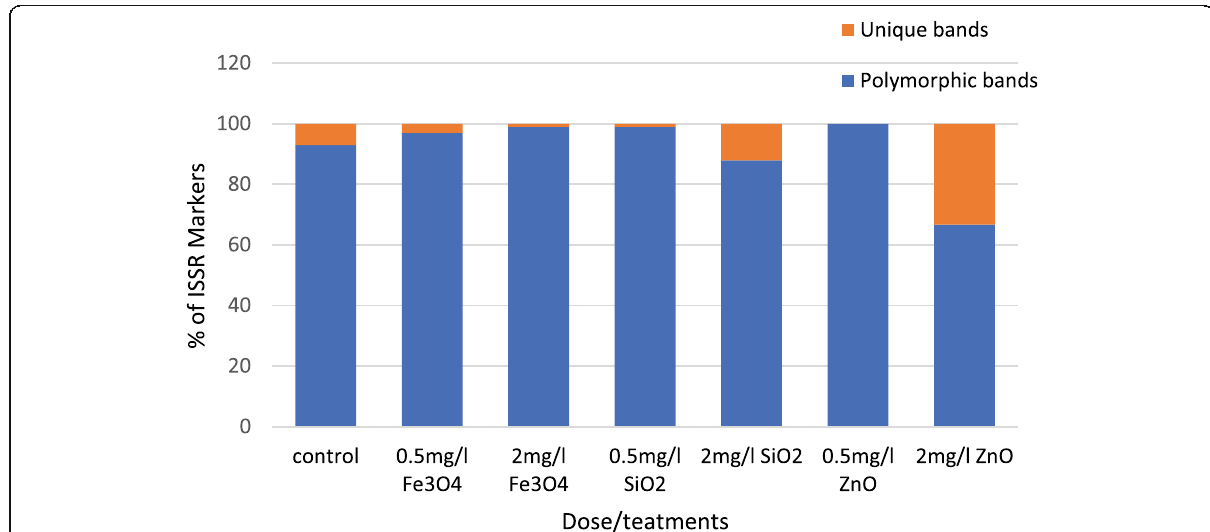
Fig. 4 Percentage of polymorphic and unique ISSR markers in Salvadora persica callus in 0.5 and 2 mg/l of Fe 3 O 4 , SiO 2 , or ZnO-treated callus of 45 days old and the